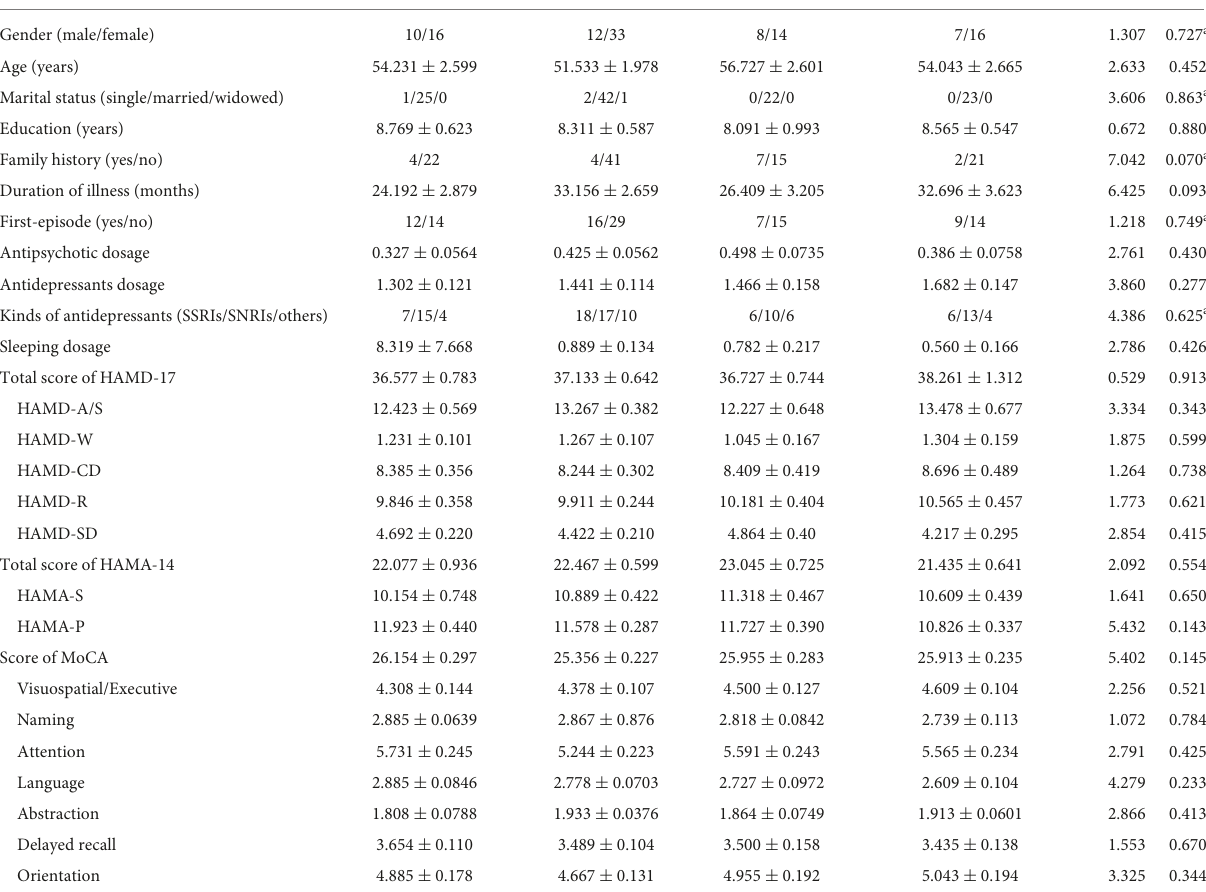
TABLE 1 Demographic and baseline characteristics of groups.